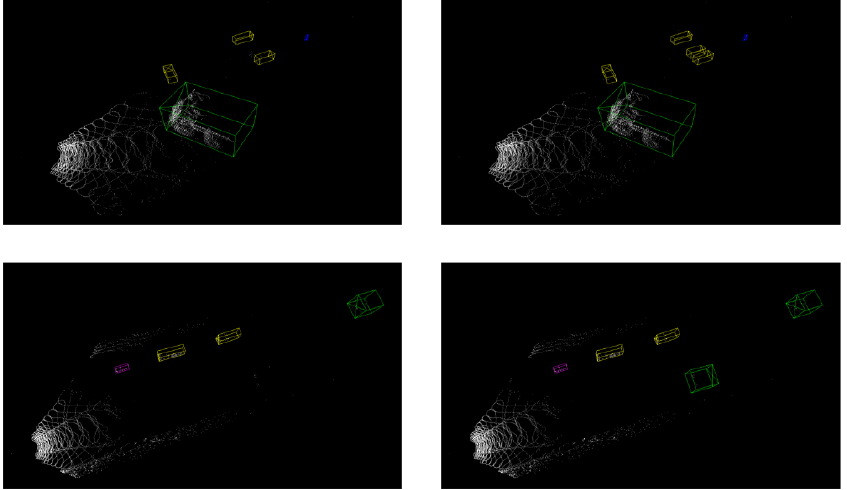
Figure 9. Comparative experiments between the baseline model and new model in object detection. The left column is the baseline model trained only on real data and the right column is the new model trained on both real data and virtual data.